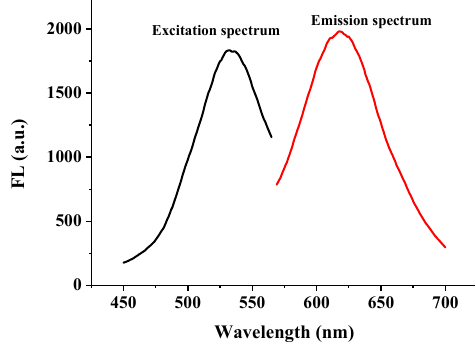
Figure 6. Fluorescence spectra of DNA2-Ag NCs.